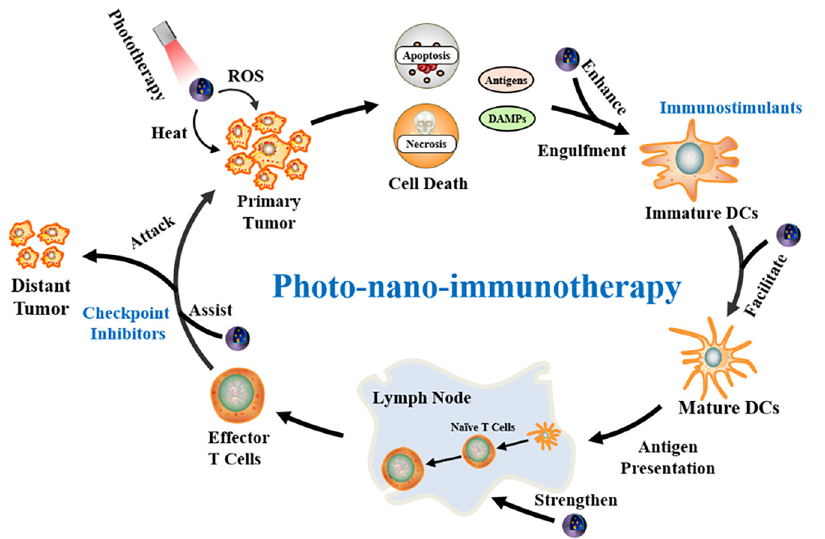
Figure 3: Schematic illustration of the nanomaterial-based